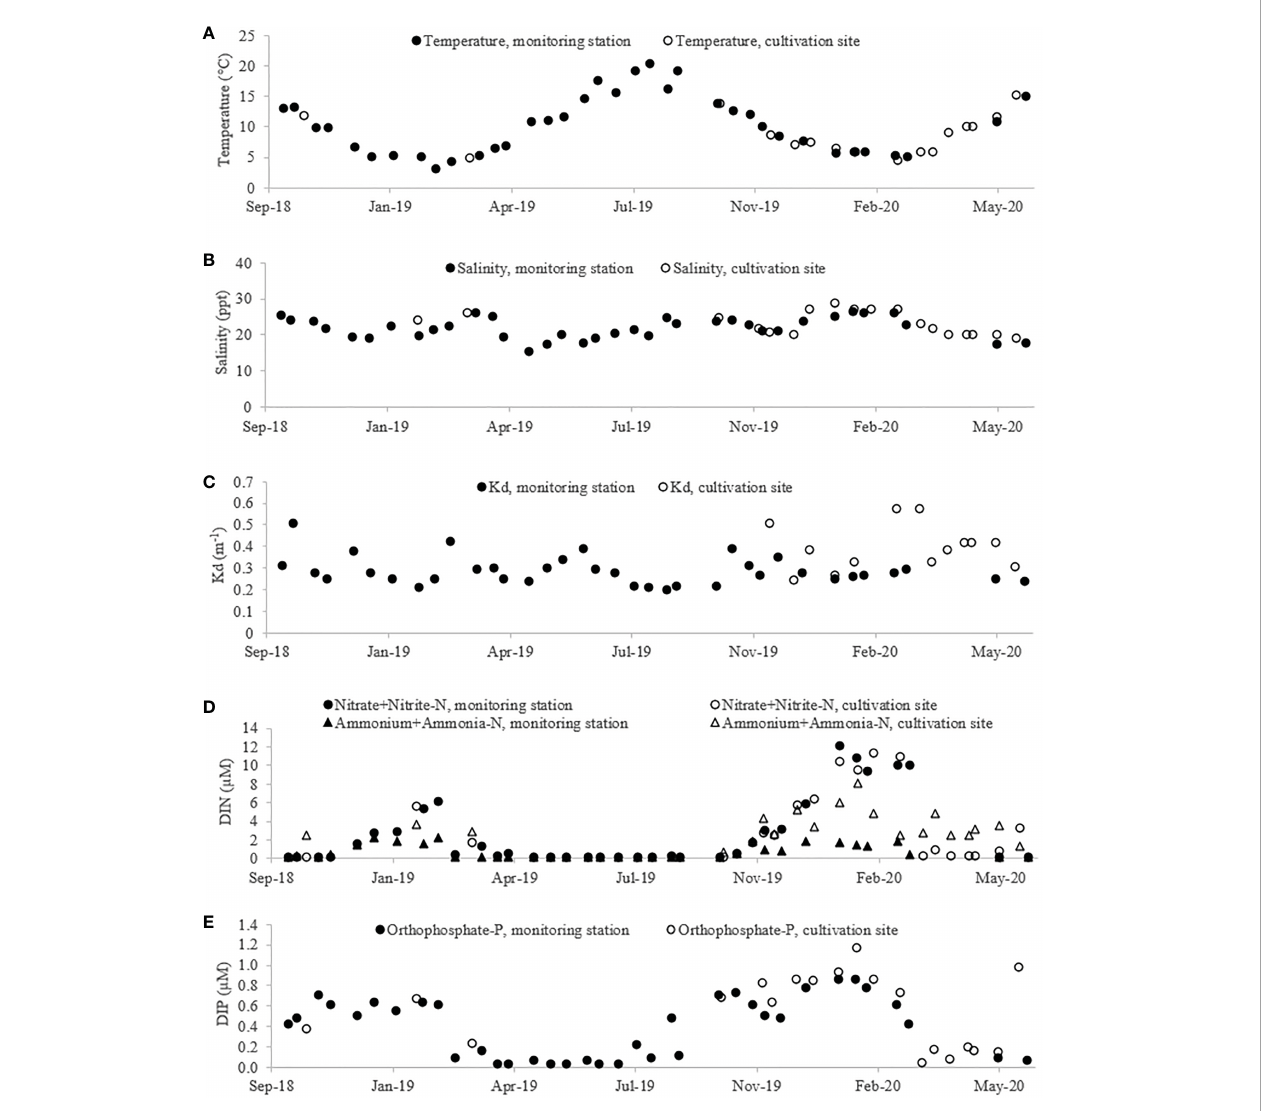
FIGURE 4 Environmental parameters registered during the full cultivation period (October 2018 – July 2020): (A) Temperature, (B) salinity, (C) light extinction coef fi cient (Kd), (D) concentration of dissolved inorganic nitrogen (DIN – nitrate+nitrite and ammonium+ammonia-N) and (E) concentration of dissolved inorganic phosphate (DIP – orthophosphate-P). Closed symbols represent monitoring data obtained from the nearby national environmental monitoring station (VEJ0006870, Figure 1) maintained by the Danish National Monitoring Programme (NOVANA). Open symbols represent measurements made at the cultivation site as part of this study. Data are shown as single measurements, and nutrients/salinity/temperature were measured at 1-3 m